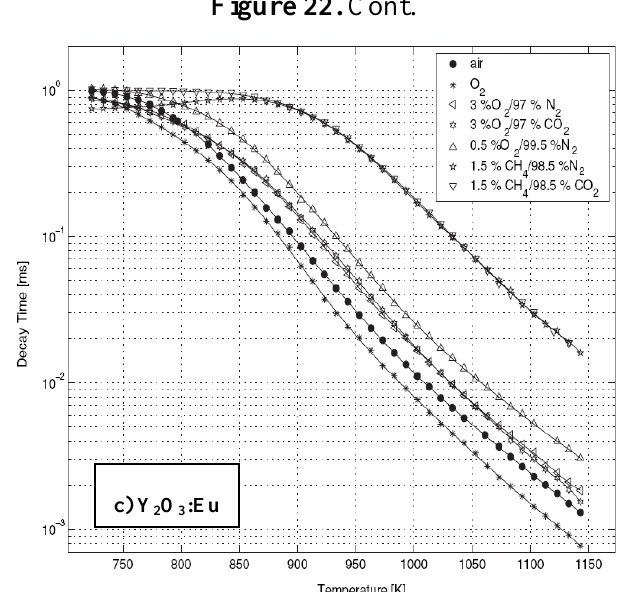
Figure 23. Variation in lifetime decay time of La